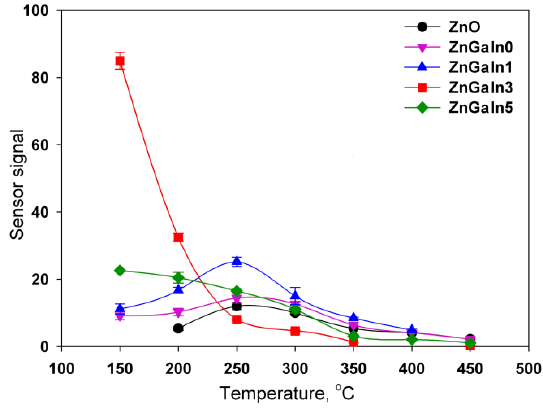
Figure 4. Temperature dependencies of sensor signals to 0.7 ppm NO 2 for ZnO(Ga, In)